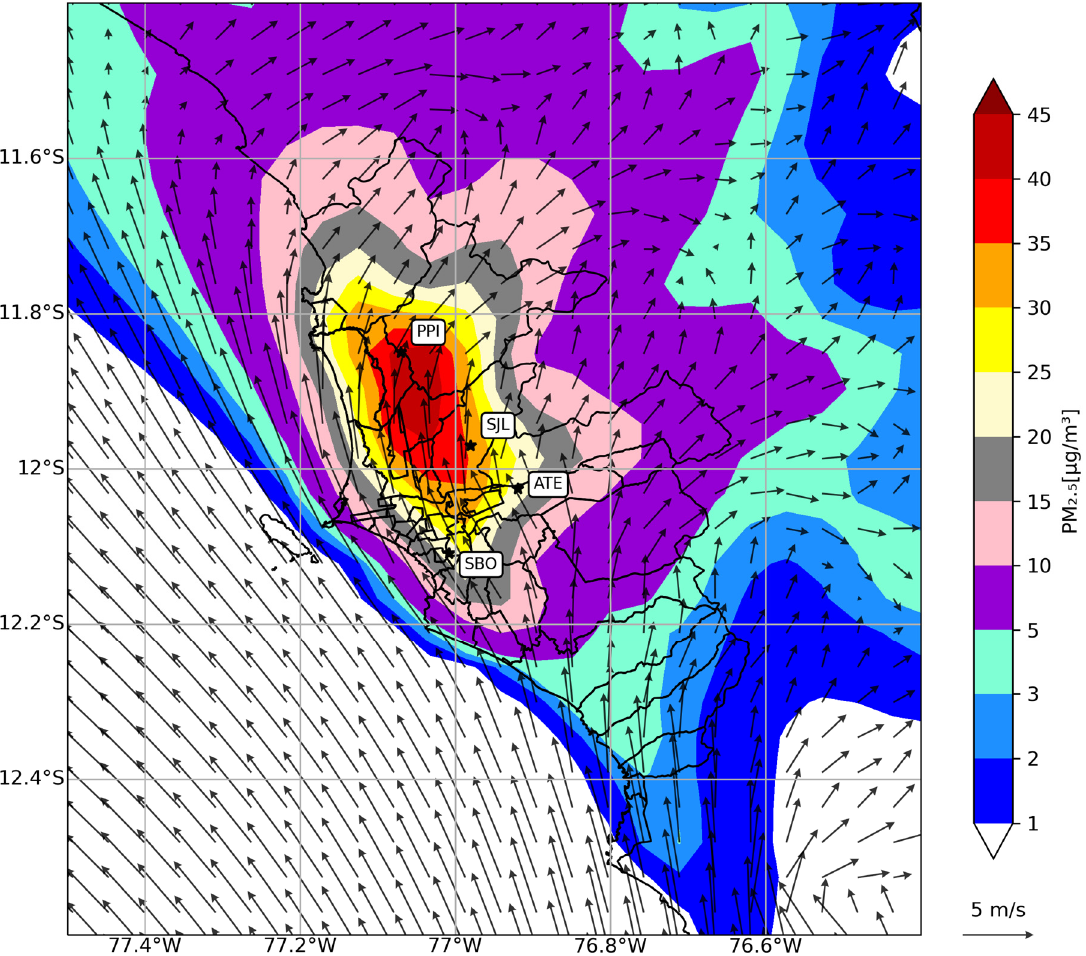
Figure 10. Control-WithoutAerosol: Simulation of the effect of vehicular aerosol emission on PM 2.5 concentration (µg/m 3 ). Namely, ATE, SBO, SJL and PPI illustrate the locations of the stations: ATE is Ate, SBO is San Borja, SJL is San Juan de Lurigancho (SJL), and PPI is Puente Piedra. A colorful vertical legend indicates the different PM 2.5 values.